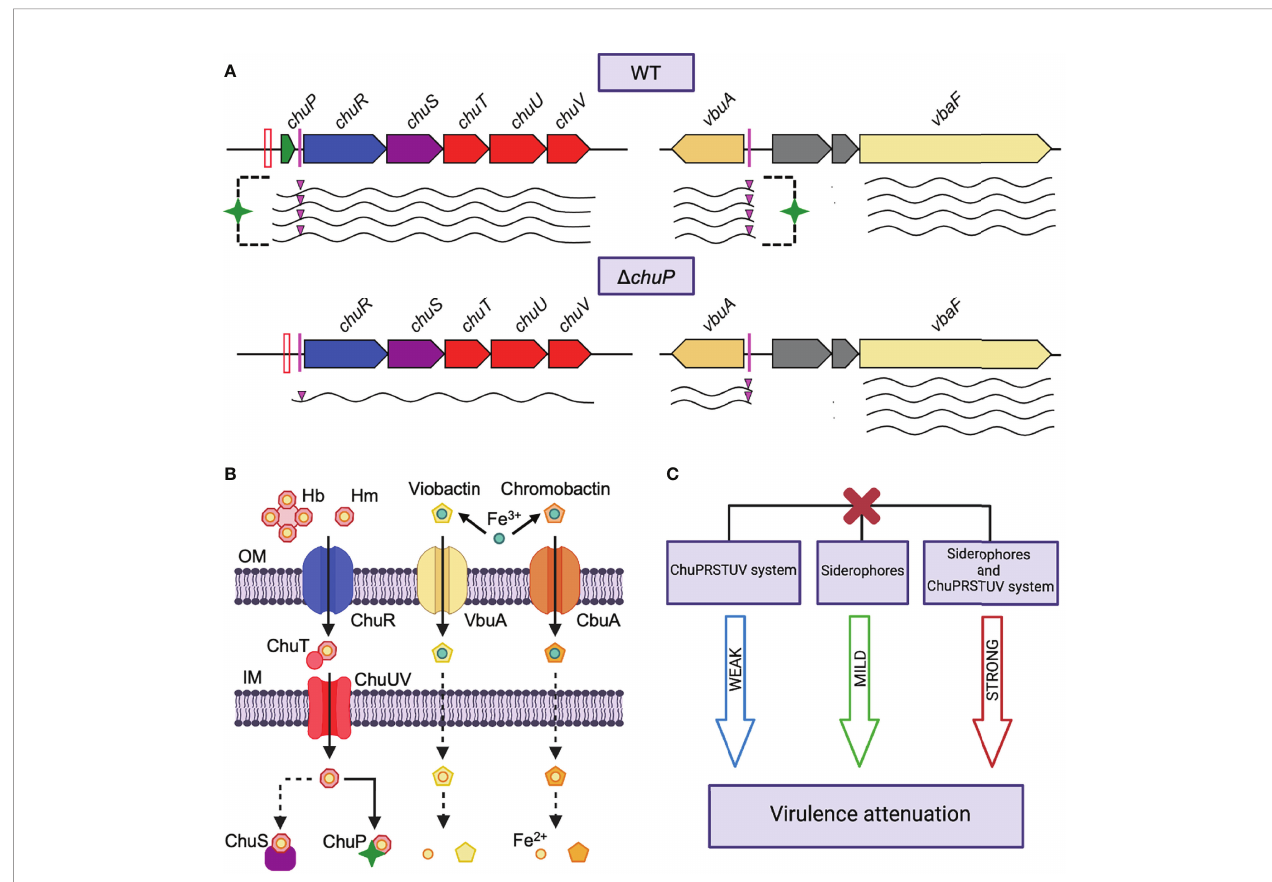
FIGURE 6 | Model of how C. violaceum connects iron acquisition by heme and siderophore during infection. (A) Regulatory function of ChuP over chuR and vbuA . (B) Iron acquisition systems in C. violaceum for the uptake of heme (this work) and the siderophores viobactin and chromobactin (Batista et al., 2019). (C) Interplay between the uptake of heme and siderophore in the C. violaceum virulence. We propose that ChuP links heme and siderophore utilization by acting as a positive regulator of chuR and vbuA , which encode TBDRs for the uptake of heme (ChuR) and the siderophore viobactin (VbuA). In addition to Fur derepression, the expression of chuR and vbuA depends on ChuP under iron de fi ciency, possibly by a post-transcriptional mechanism involving HPRE (HmuP-responsive elements) sequences found in the 5 ’ -UTR of the chuR and vbuA transcripts. In the absence of ChuP, the abundance of chuR and vbuA transcripts decreases, causing a reduction in heme and viobactin utilization. Different levels of virulence attenuation occurred when the ChuPRSTUV system (weak), the siderophores (mild), or both (strong) were deleted, indicating that C. violaceum prefers siderophores over heme during infection but relies on heme in the absence of siderophores. Red bars, Fur boxes; Pink bars and triangles, predicted HPRE sequences; Green stars, ChuP protein; Waved lines, mRNAs; Red X, mutant strains; OM, Outer membrane; IM, Inner membrane; Dashed lines, unknown